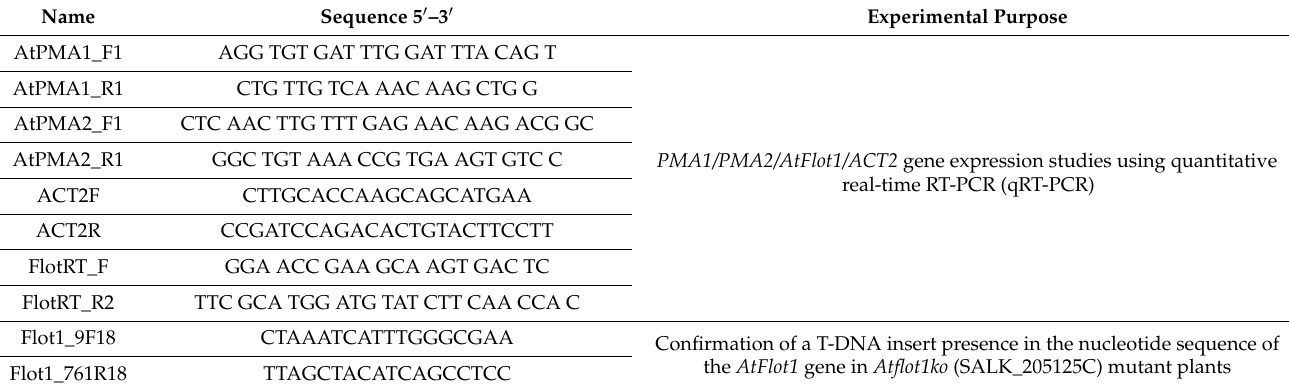
Figure 1. Structure of the AtFlot1ko allele of the A. thaliana AtFlot1 gene. ( a ) Arrangement of the functional elements in the AtFlot1 gene. Here, 1 and 2 indicate exons and untranslated regions. Intron sequence is indicated with the broken line. The triangle indicates the T-DNA insert in the Atflot1ko (KO) allele. Arrows in the bottom line indicate positions of primers used. ( b ) Determination of homozygosity for the AtFlot1 gene in the SALK_205125C mutant plants by PCR using a pair of primers, namely Flot1_9F18 and Flot1_761R. The amplification products were separated on an 1% non-denaturing agarose gel containing 0.5 µ g/mL ethidium bromide; 1—WT, 2—molecular weight ladder, 3— Atflot1ko . ( c ) Expression of the AtFlot1 gene in the wild-type (WT) and AtFlot1ko A. thaliana mutant plants. Means ± SE are given ( n = 3). Different letters indicate statistically significant differences between the samples (ANOVA; p < 0.05). Table 1. Primers used in this